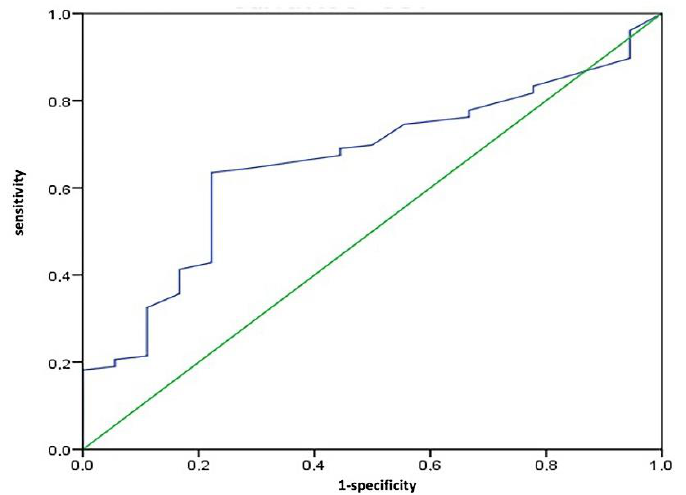
Figure 1. Receiver operator characteristic (ROC) curve for maximum standardized uptake value (SUVmax) cut-off, showing that the most effective cut-off was 3.65 (AUC 0.659, 95%CI 0.542–0.77).